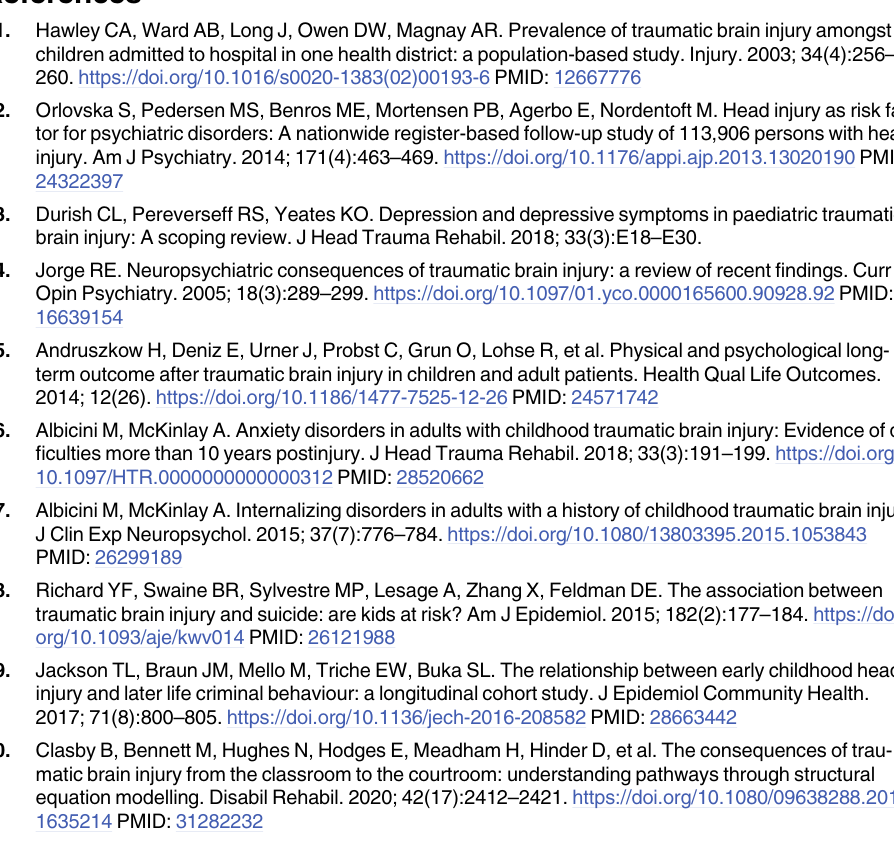
S1 Fig. Flow diagram presenting the number of records and pupils excluded at each stage of data cleaning and data